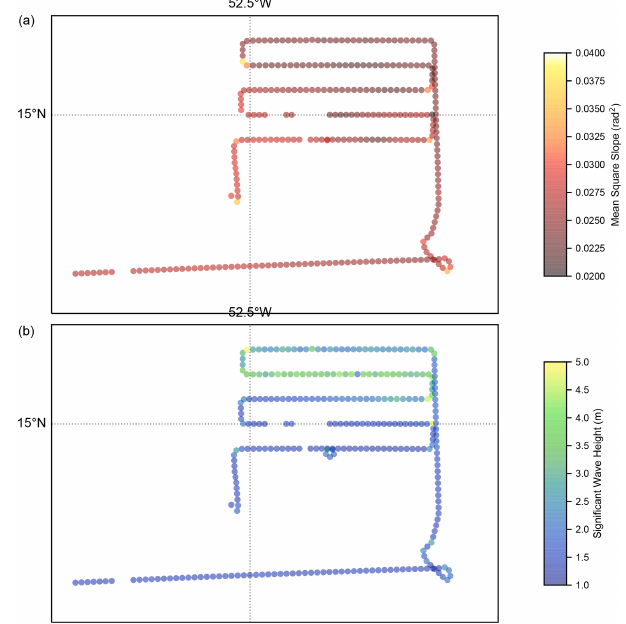
Figure 12. Observations of surface wave state from the Wide Swath Radar Altimeter (WSRA) during the P-3 flight of 19 January 2020. (a) Mean square slope (rad 2 ). (b) Significant wave height (m).